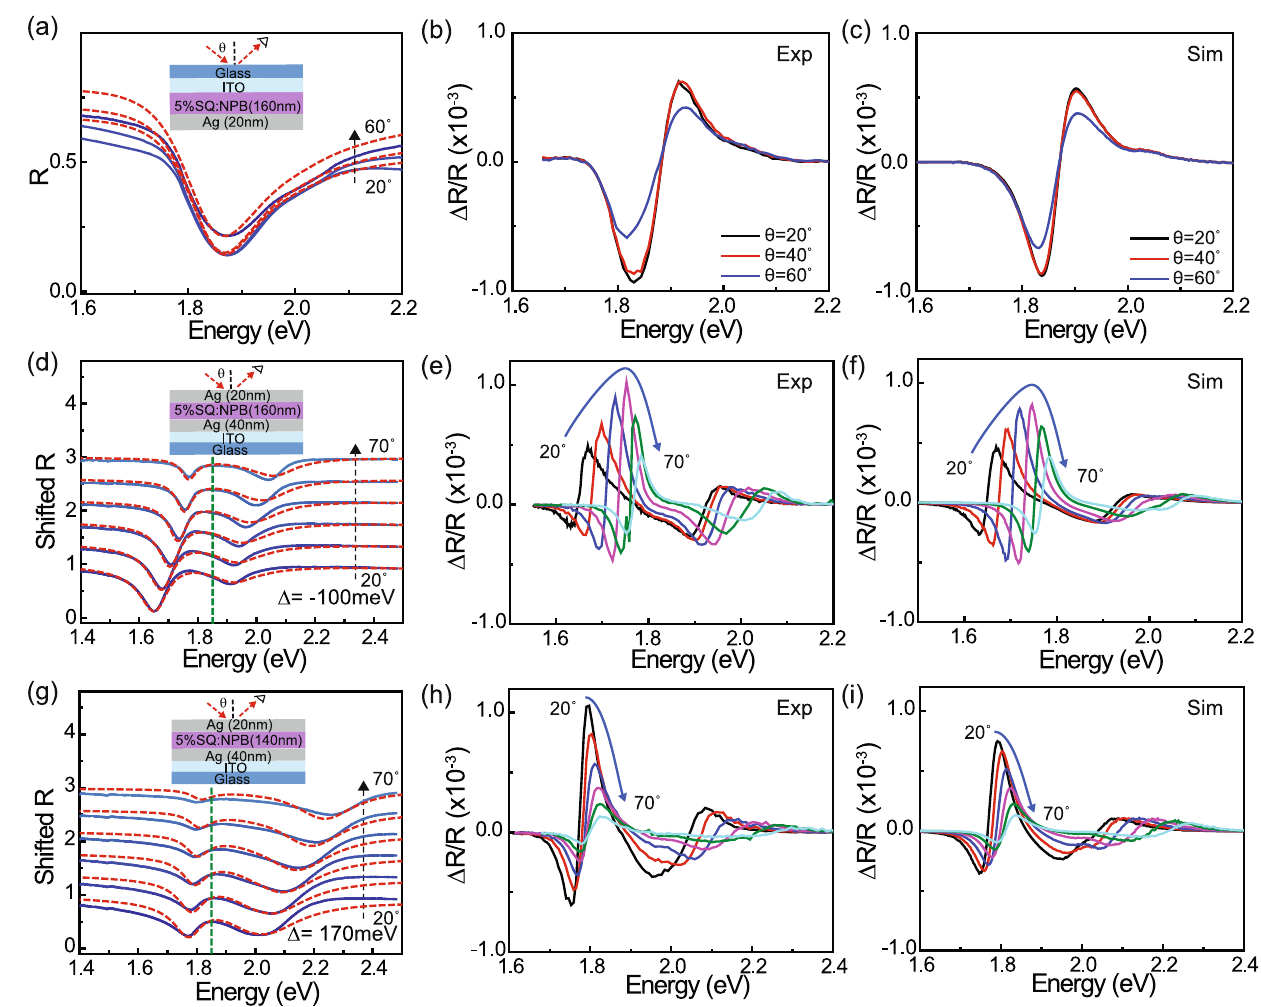
Fig. 2 | Microcavityelectrore fl ectance atlow SQ concentration. Re fl ectivity and EAdatafordeviceswitha5wt%SQ:NPBactivelayer. a Angle-dependents-polarized re fl ectivity spectra measured for a half-cavity control device (illustrated in the inset) together with corresponding transfer matrix simulations (red dashed lines) based on the 5wt% SQ:NPB optical constant dispersion in Fig. 1. b Measured and c simulated electrore fl ectance spectra for the control device at different angles. The simulation is carried out via the transfer matrix model by red-shifting and strengthening the Lorentz oscillators used to model the SQ optical constant